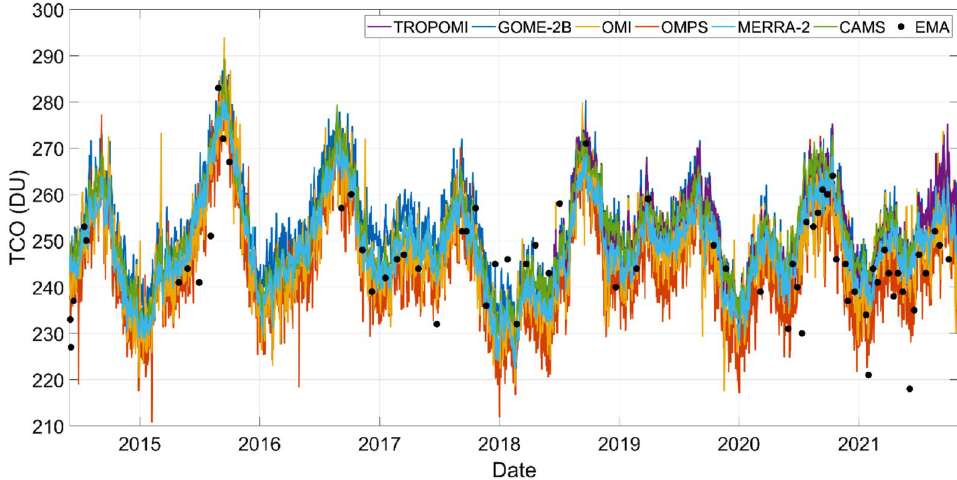
Figure 1. Total column ozone (TCO) time series. Measurements from Quito ozone soundings (EMA USFQ) are depicted by black dots. Satellite observations from TROPOMI/S5P, GOME-2/METOP-B, OMI/Aura, OMPS/ Suomi NPP, as well as reanalysis products MERRA-2 and CAMS, are daily data and are depicted with colored lines (see figure legend).